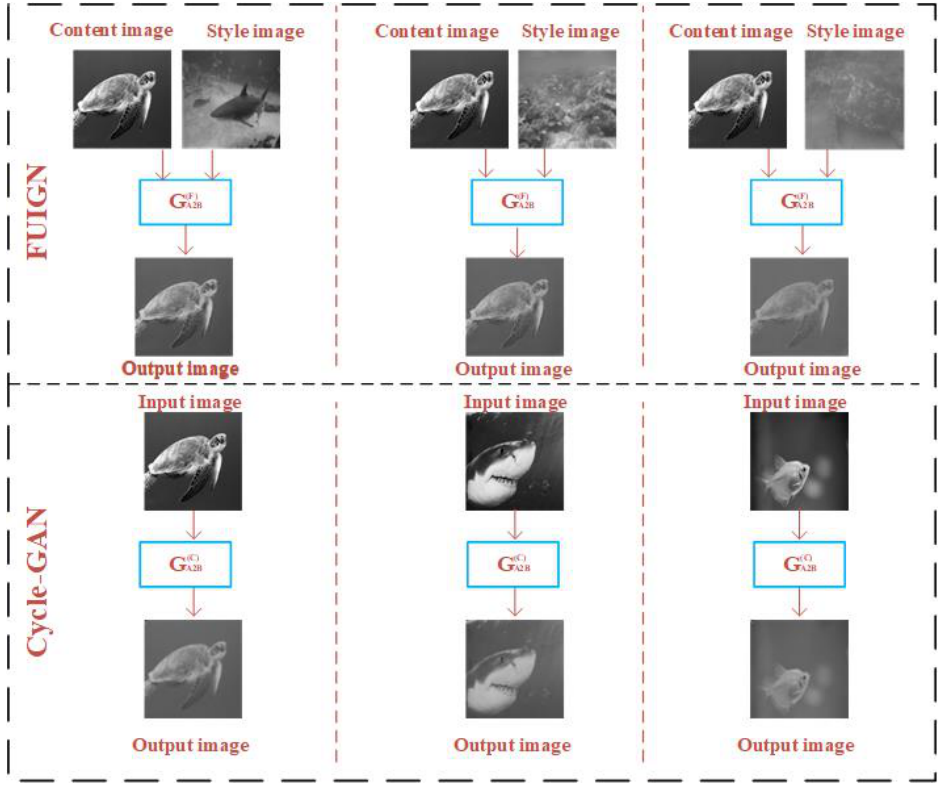
Figure 6. Comparison of the underwater paired images generated by the G (F) Cycle-GAN.